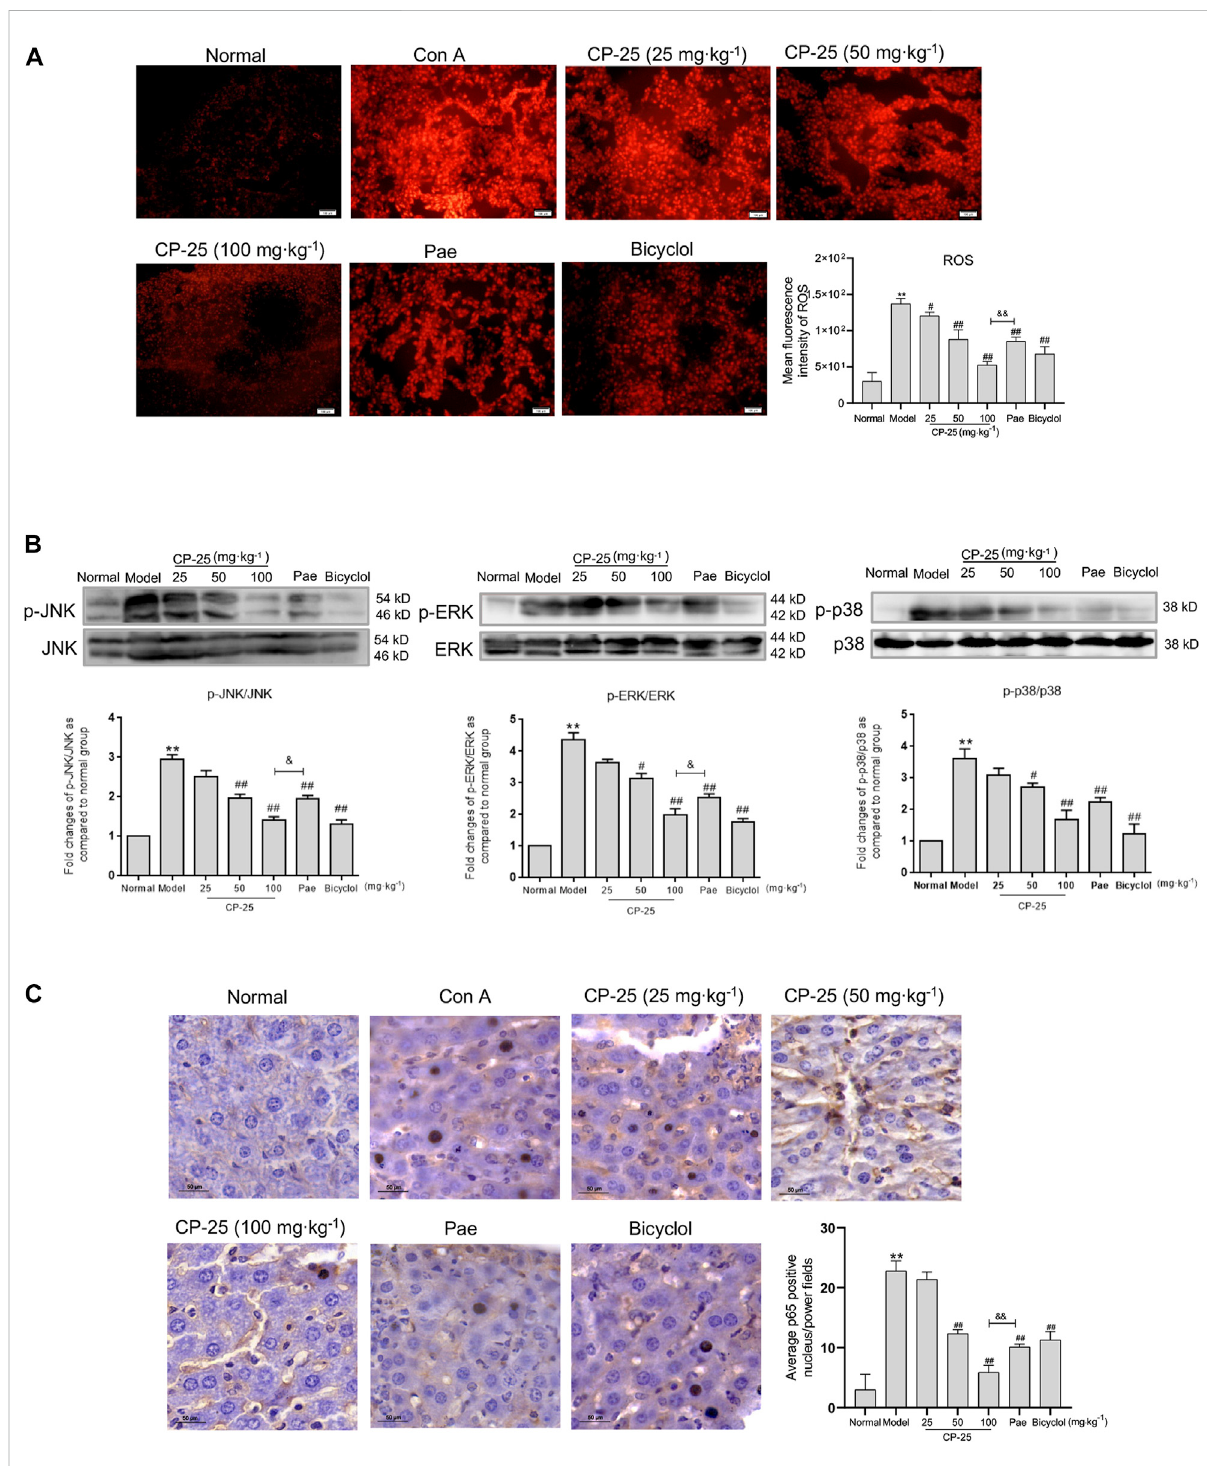
FIGURE 4 CP-25inhibitedtheactivationofMAPKpathwayandnucleartranslocationofNF- κ BmediatedbyROS invivo . (A) Representativemicrographsof ROS production in liver tissues were stained with DHE (Scale bar = 100 μ m), and was quantitated by measuring the fl uorescence intensity. (B) Representative immunoblotting bands of p-JNK, p-ERK and p-p38 in ConA-injected mice were showed, the semi-quantitative analysis was shown as the bar diagram. Densitometry values were expressed as-fold change relative to the normal group. (C) Representative images of NF- κ B nuclear translocation in liver tissues were detected by immunohistochemistry staining (Scale bar = 50 μ m). Results from three independent experiments are reported as the means ± SD. **p < 0.01 versus normal, # p < 0.05, ## p < 0.01 versus model, & p < 0.05, && p < 0.01 versus paeoni fl